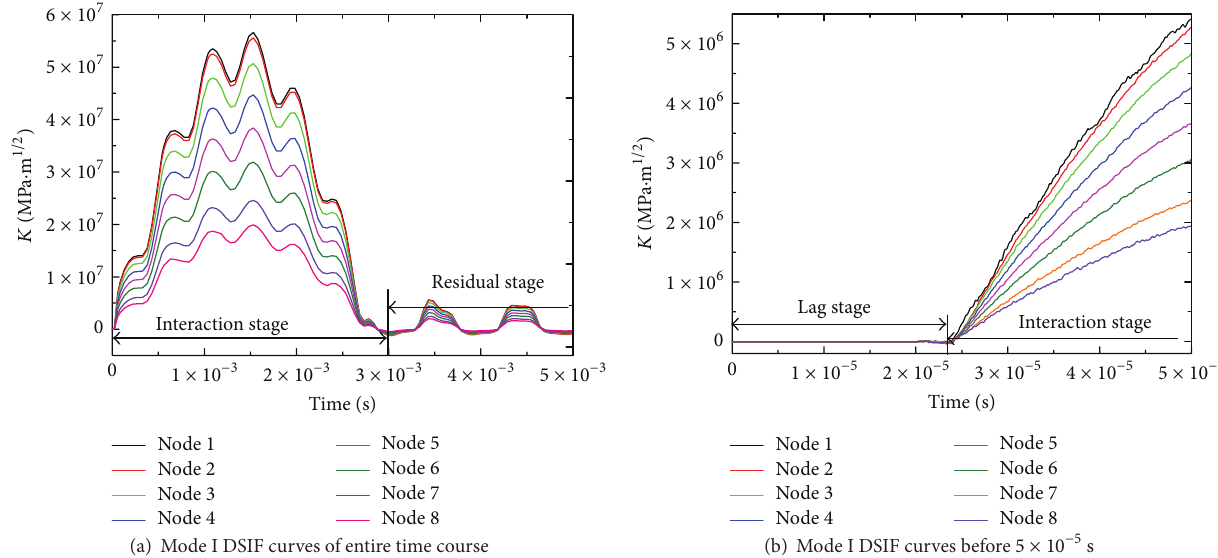
Figure 7: The mode I DSIF time history of node 1 to node 8 at crack tip with the impact velocity of 5m/s and crack length of 0.02 m.